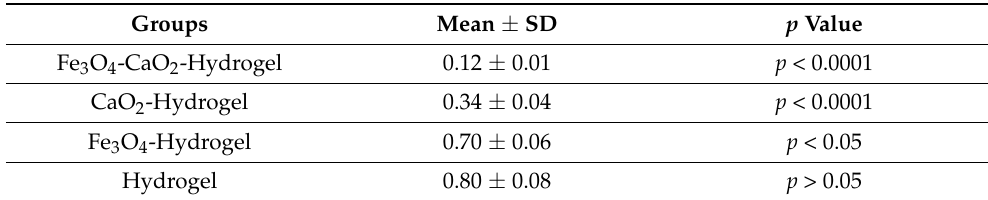
Table 1. Specific values for crystal violet